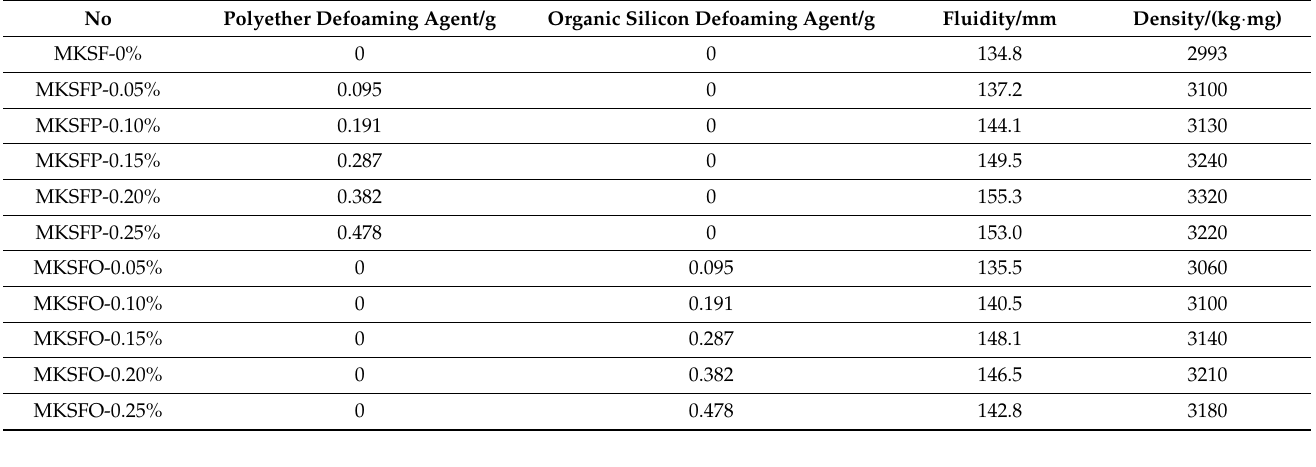
Table 9. Mobility and density.